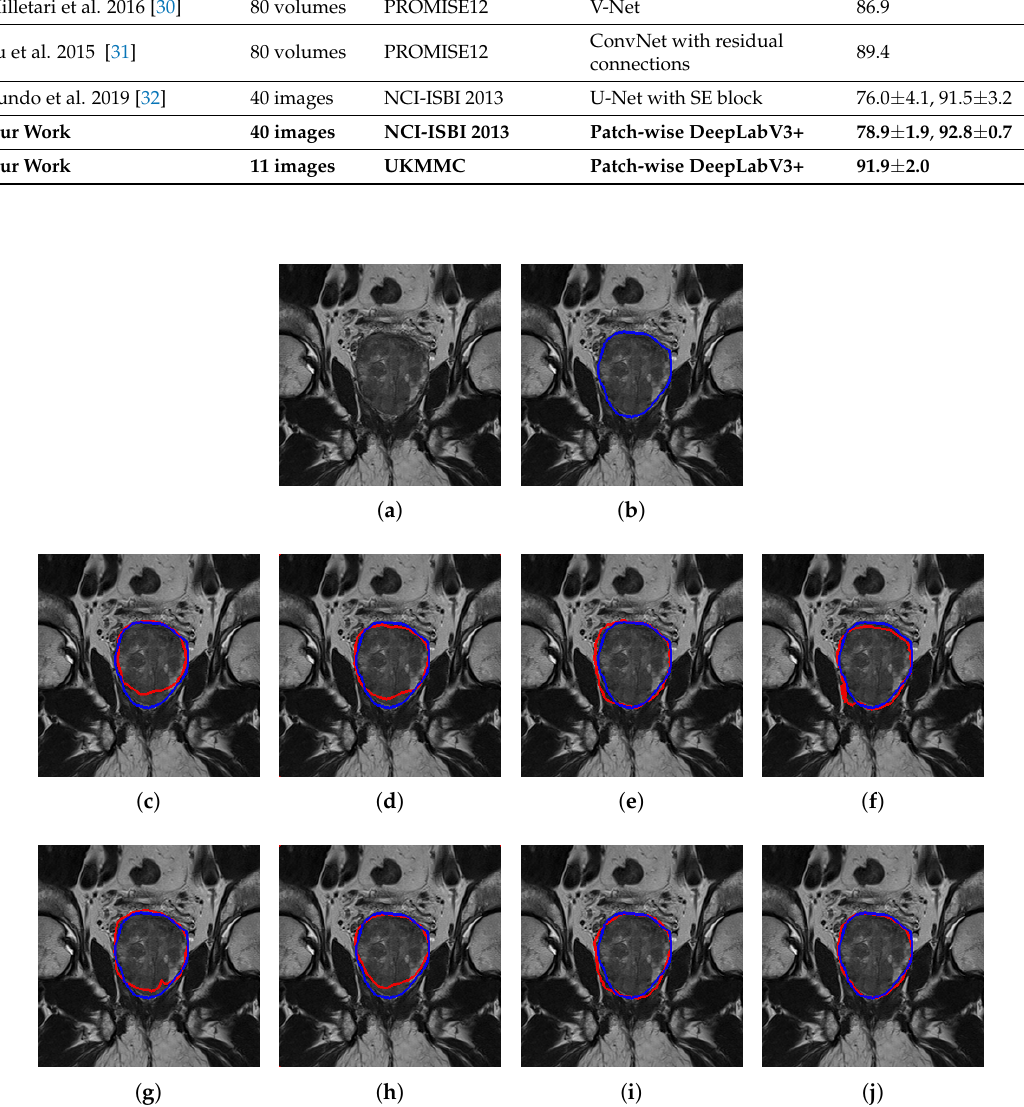
Figure 7. Semantic segmentation of WG prostate T2W MRI, from UKMMC dataset. ( a ) Original image, ( b ) ground truth boundary where predicted boundary (red), overlay on the ground truth (blue), based on the method without patch extraction using, ( c ) FCN, ( d ) SegNet, ( e ) U-Net and ( f ) DeepLabV3+, and based on patch extraction using ( g ) FCN, ( h ) SegNet ( i ) U-Net and ( j )